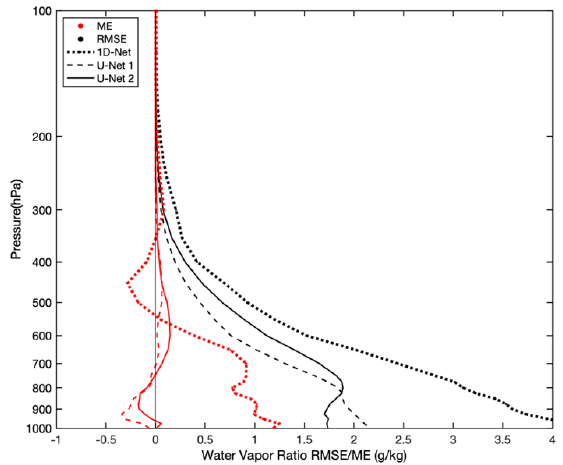
Figure 11. The same as Figure 10 except for water vapor mixing ratio.